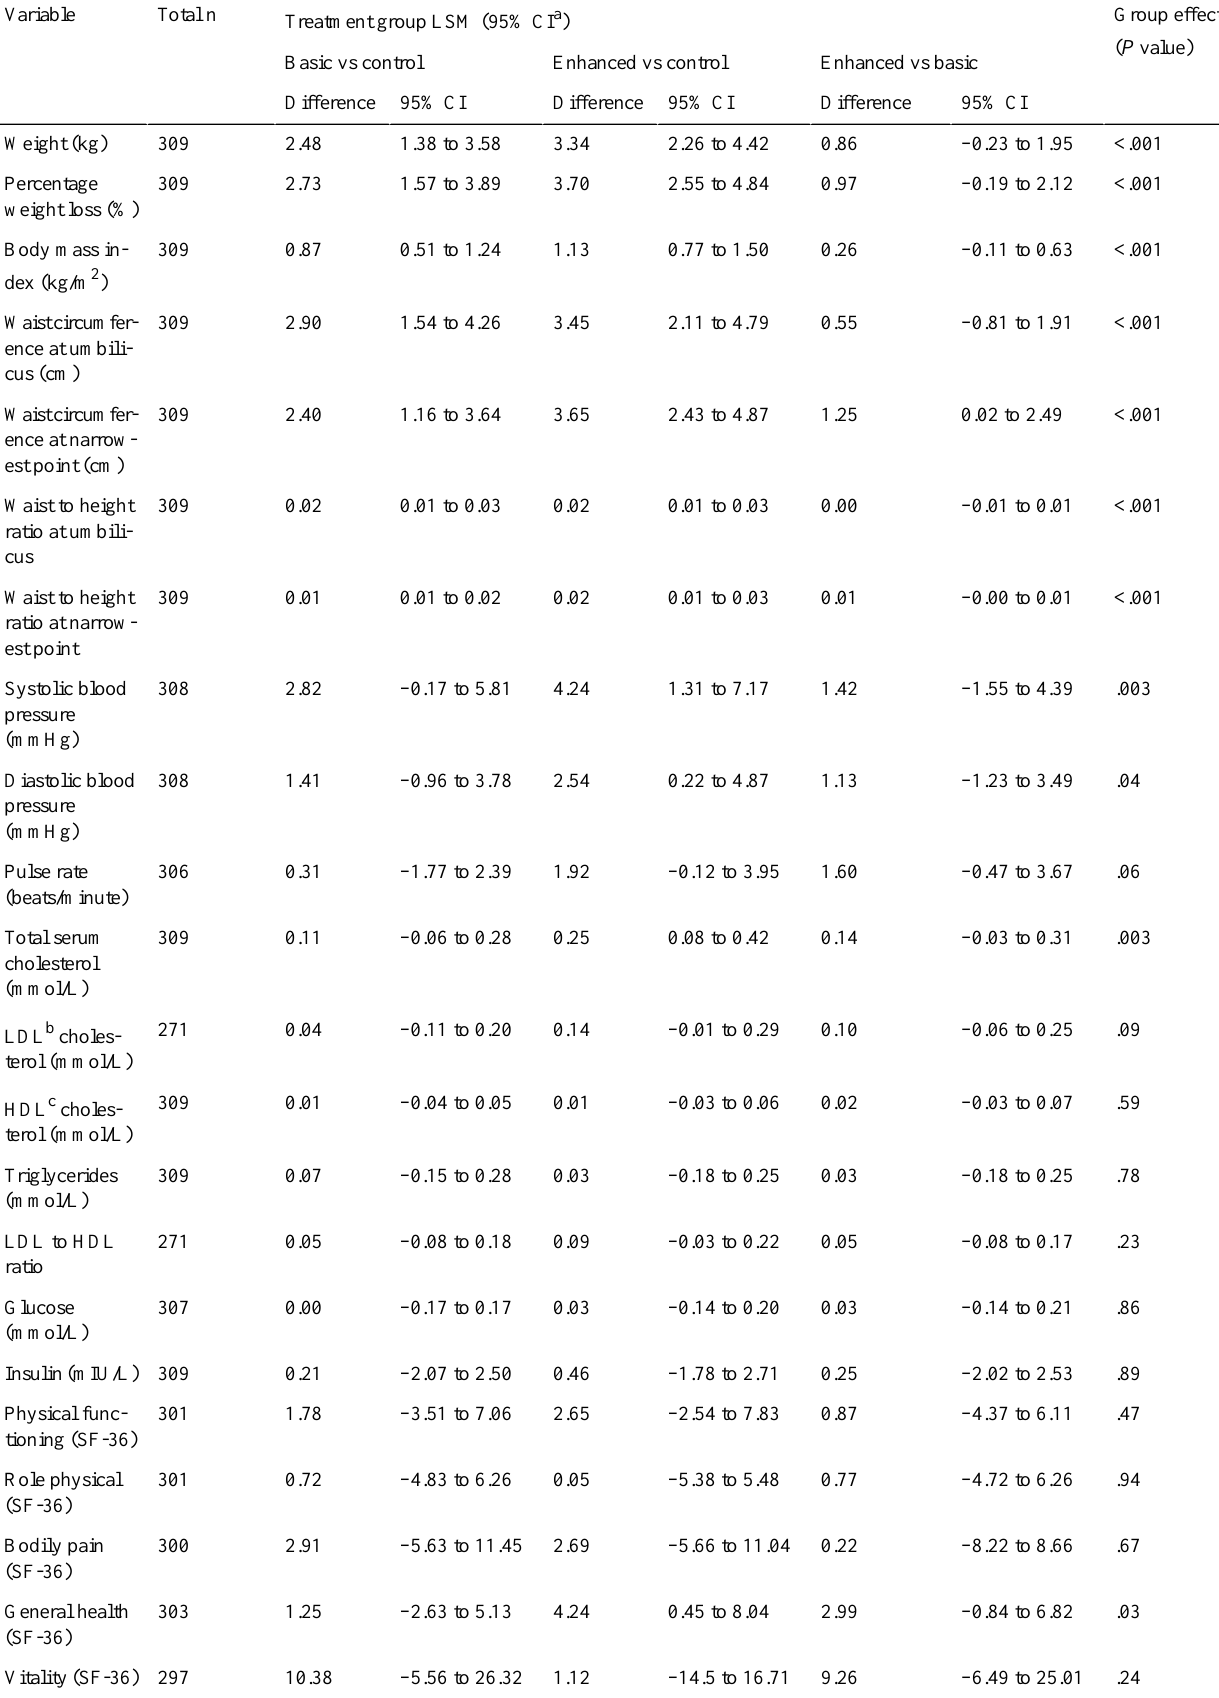
Table 3. Absolute and least square mean (LSM) differences between groups at 12 weeks (intention-to-treat population).